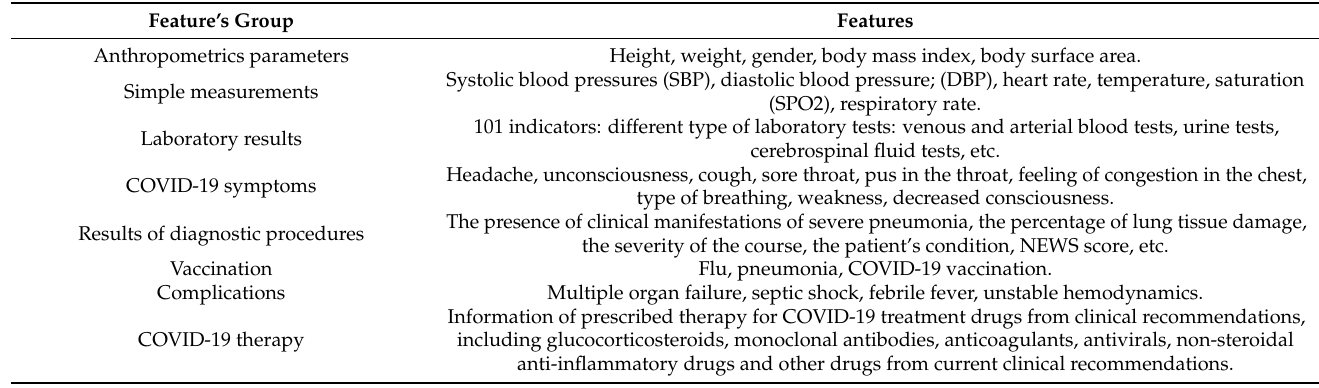
Table 2. Medical indicators for treatment